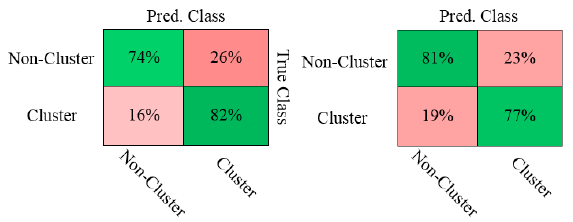
Figure 5 . Overview classification Stanford 2D-3D-Semantics Dataset (2D-3D-S): The averaged recall matrix (left) and the av- eraged precision matrix